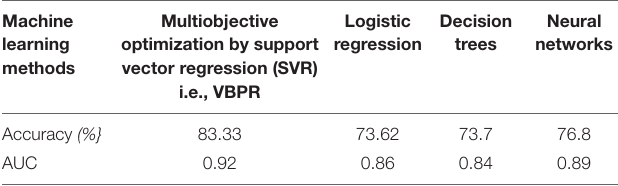
TABLE 3 | Performance comparison with the existing standard machine learning methods.